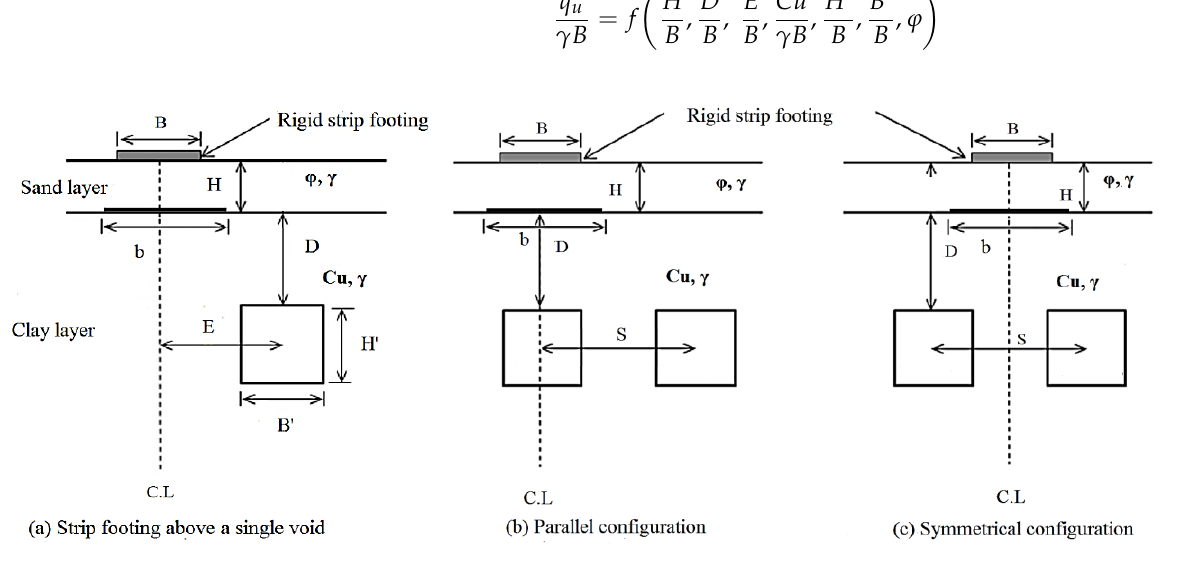
Figure 1. Schematic of the model.